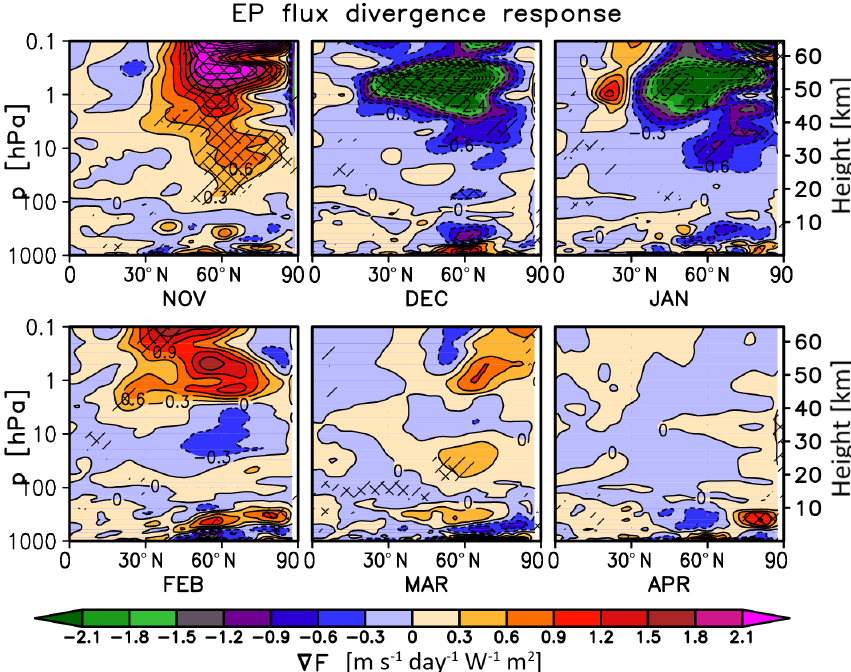
Figure 8. Monthly mean November–April scaled EP flux divergence (i.e. ( ∇ · F )/(ρ · a · cos φ) ; see Andrews et al., 1987) response (ms − 1 day − 1 W − 1 m 2 ) in UM-UKCA derived with MLR. Single and double hatching indicates statistical significance on the 90% and 95% level, respectively ( t test). Contour spacing is 0.3ms − 1 day − 1 W − 1 m 2